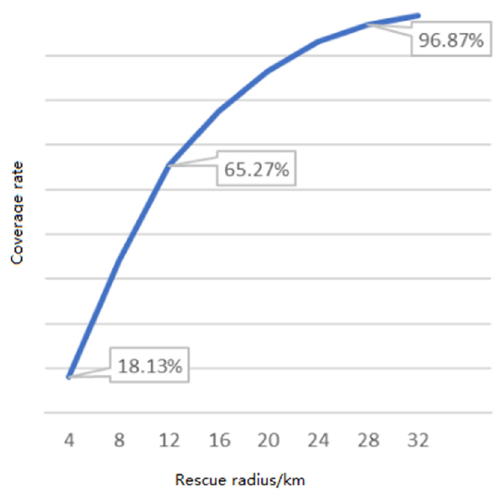
Figure 5. Change pattern in rescue radius and coverage rate.